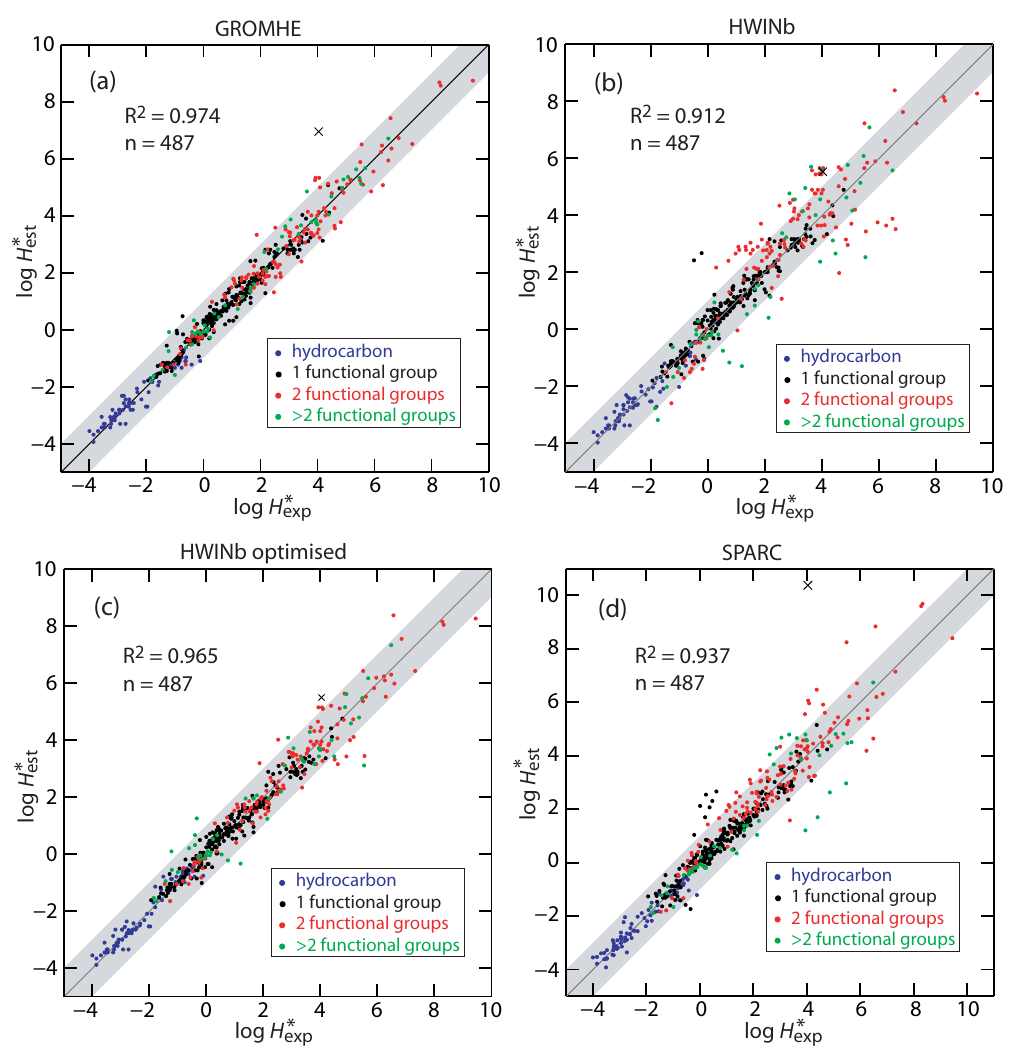
Fig. 3. Scatter plot of estimated versus experimental log H ∗ for (a) GROMHE method, (b) HWINb method, (c) HWINb optimised method and (d) SPARC-v4.2 method. The line is the y = x line and the grey area represents agreement within one log unit. The ( x ) symbol represents oxo-acetic